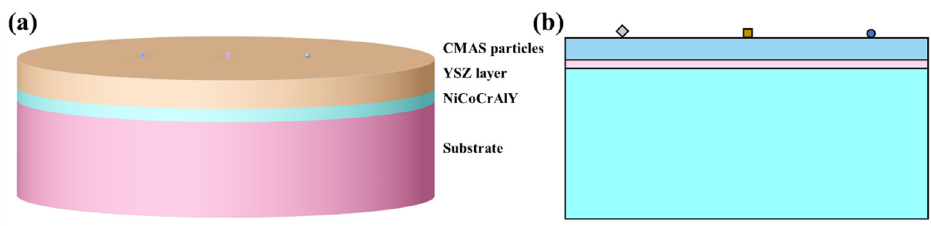
Figure 2. ( a ) Schematic illustration of the three-dimensional model, ( b ) simplified axisymmetric model.